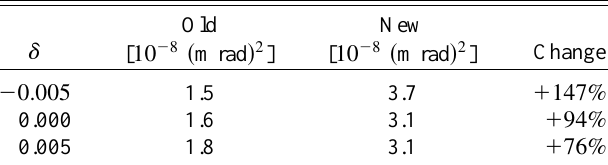
TABLE V. Volume of stable four-dimensional phase space af- ter 64 turns: final solution.